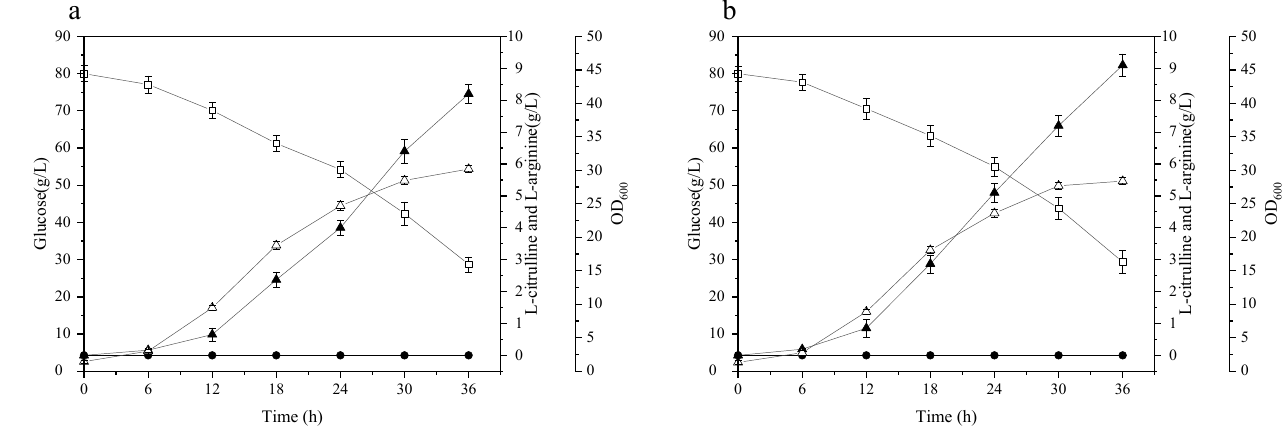
Figure 4. Batch fermentation of CRBGC ( a ) and CRBGCo ( b ) strains in shake flasks. Signal denotes: filled triangle, L-citrulline; filled circle, L-arginine; empty square, glucose; and empty triangle, OD 600 . The error bars represent the standard deviation of three independent replicates.